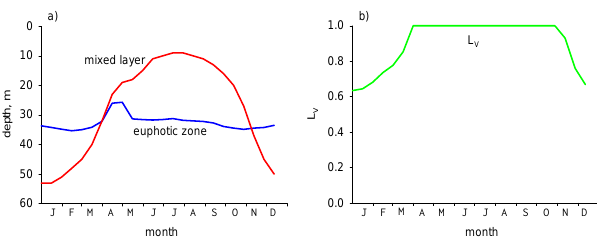
Figure 1. Forcing used by Riley (1946) in his model of George’s Bank: (a) depths of euphotic zone and mixed layer; (b) diminution in photosynthesis due to light limitation ( L V ) .